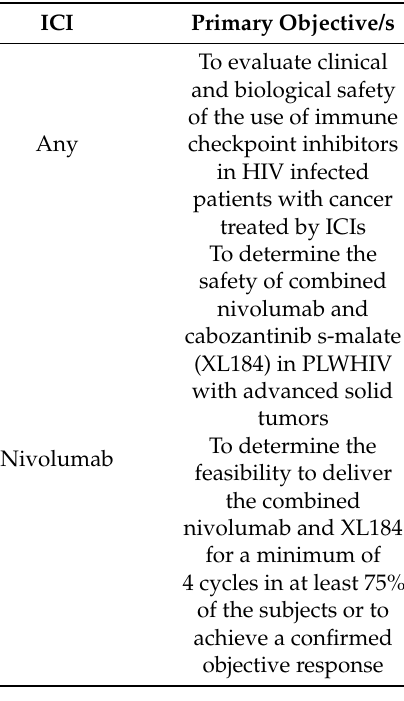
Table 2. Studies registered on Clinicaltrial.gov assessing ICIs for treatment of cancers in PLWHIV. Search was performed on 24 April 2021. (NSCLC: Non-small-cell lung carcinoma; cART: combination antiretroviral therapy; AEs: adverse